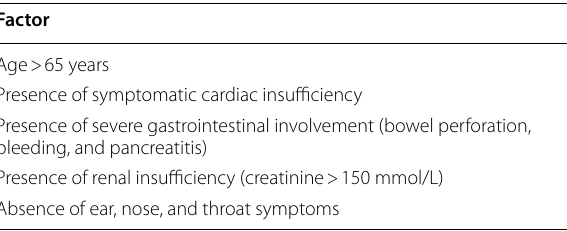
ESR erythrocyte sedimentation rate, P-ANCA perinuclear antineutrophil cytoplasmic antibodies, IVIg intravenous immunoglobulin